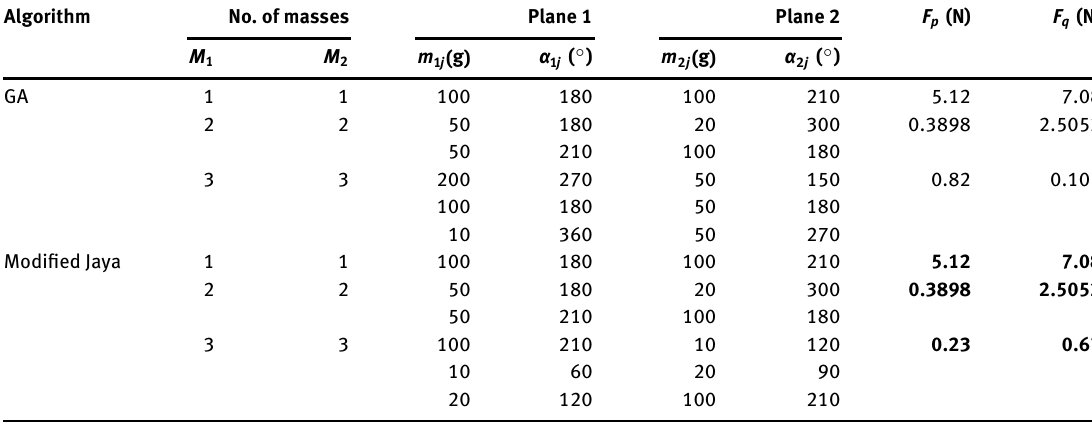
Table 7: Comparison of Optimum Results of Modified Jaya Algorithm to GA [27] for Case 1. Algorithm